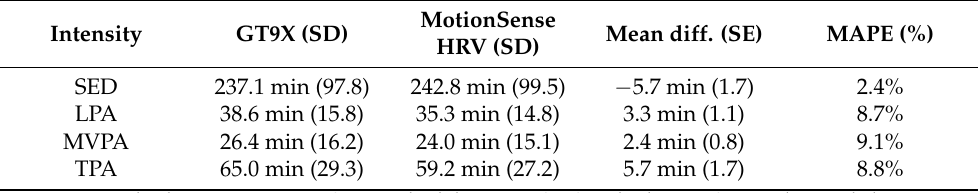
Table 4. Mean differences (SE) and Mean Absolute Percent Errors of Sedentary behavior and Physical activity (PA) between the Cosmed K5 and MotionSense HRV under simulated free-living condition. Cosmed K5 MotionSense Intensity Mean diff. (SE) MAPE (%) (SD) HRV (SD) SED 21.6 min (4.2) 25.7 min (2.6) − 4.1 min (0.9) 18.9% LPA 15.3 min (2.7) 8.5 min (1.6) 6.8 min (0.8) 44.2% MVPA 17.5 min (3.8) 19.6 min (2.4) − 2.1 min (0.9) 12.3% TPA 32.8 min (3.9) 28.2 min (2.6) 4.6 min (0.9)